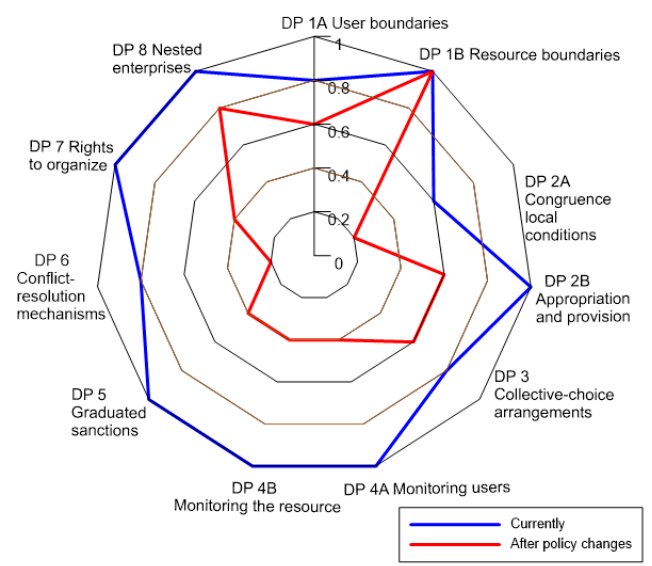
Figure 3. DPs scores in the actual situation and after policy changes.